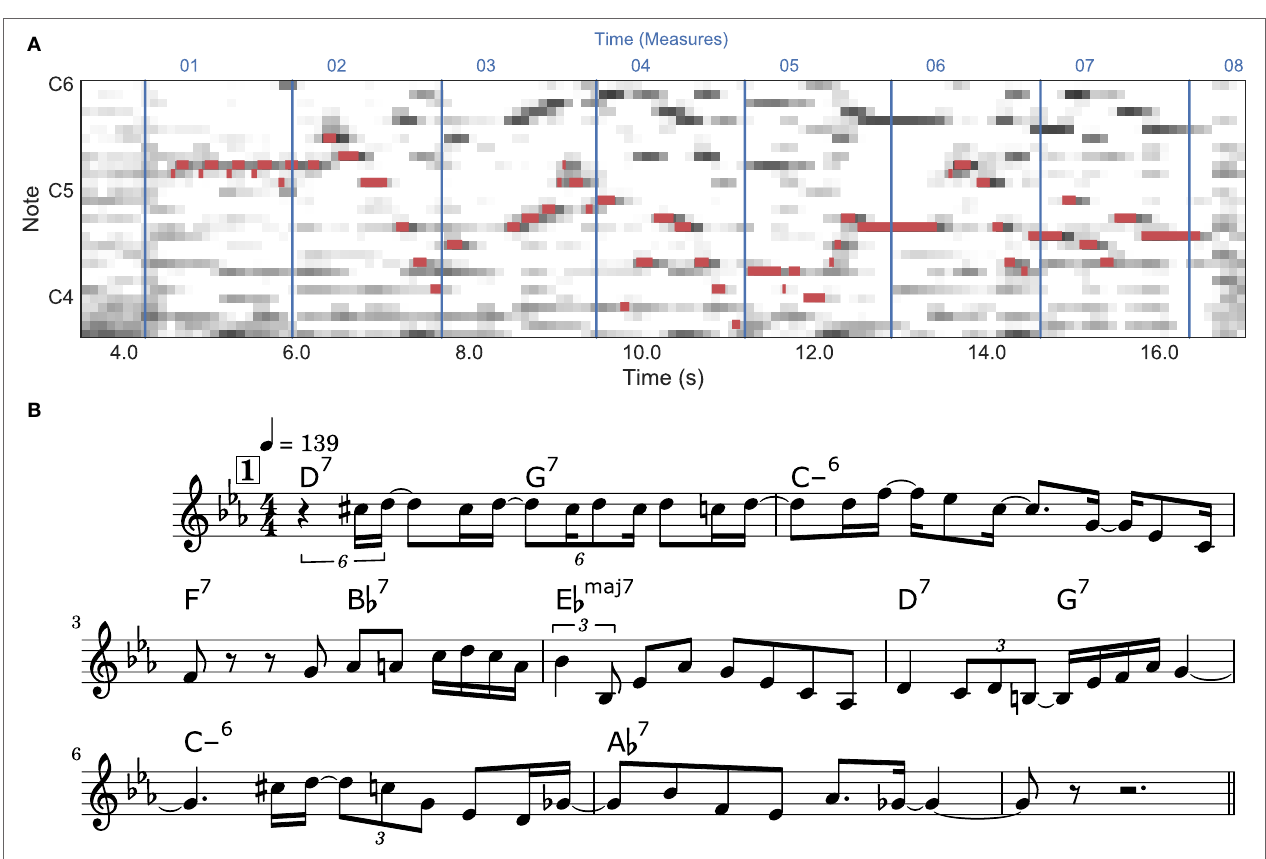
FigUre 3 | Beginning of Clifford Brown’s solo on Jordu . (a) Log-frequency spectrogram, where rectangles (red) indicate the solo transcription and vertical lines (blue) the annotated measure positions. (B) Sheet music representation of the transcribed